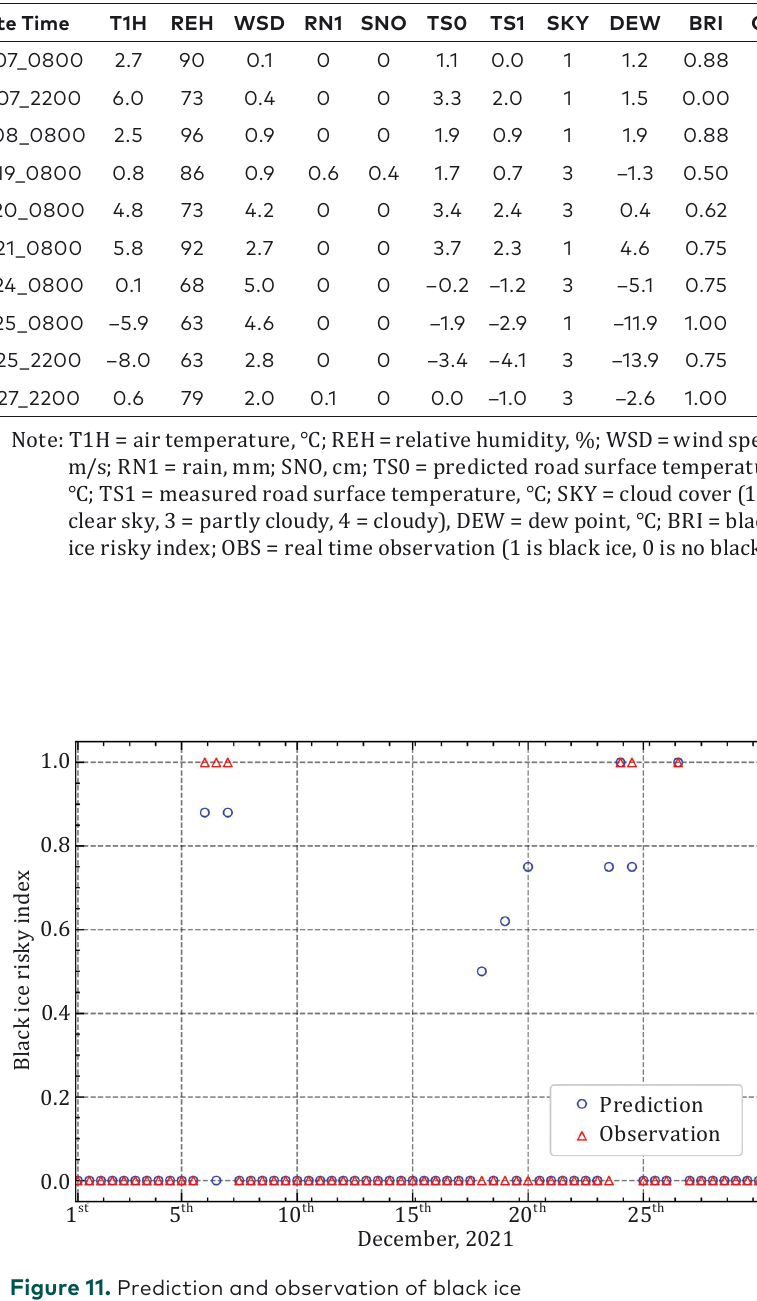
Table 1. Summary of black ice formation cases